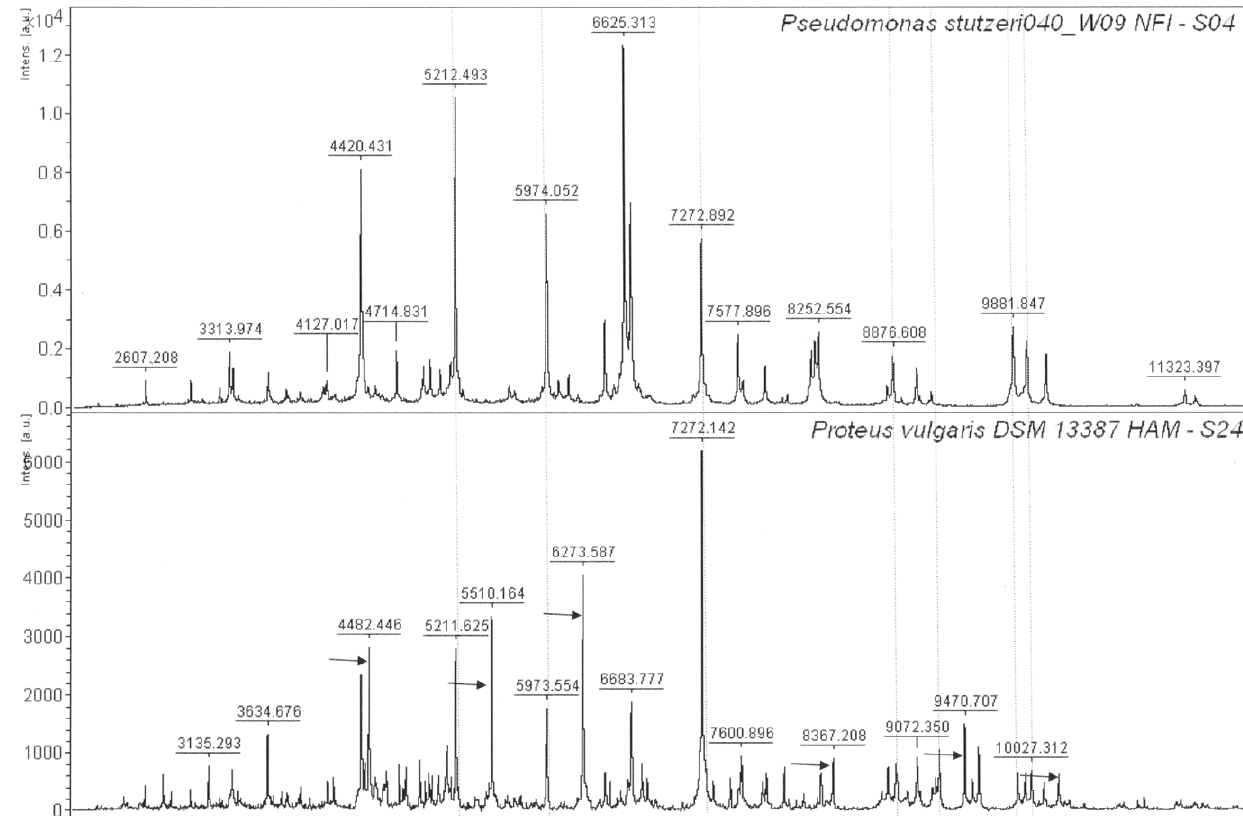
Figure 8. Comparison of Pseudomonasstutzeri and Proteusvulgaris MALDI-TOF mass spectra. Isolates S04, S24 and S38 were identified as P. stutzeri through 16S rRNA gene sequencing; however isolate S24 showed a different peak pattern and was identified as Proteus vulgaris by the Biotyper software. Examples of common peaks are indicated by vertical lines and unique peaks are indicated by the arrows.